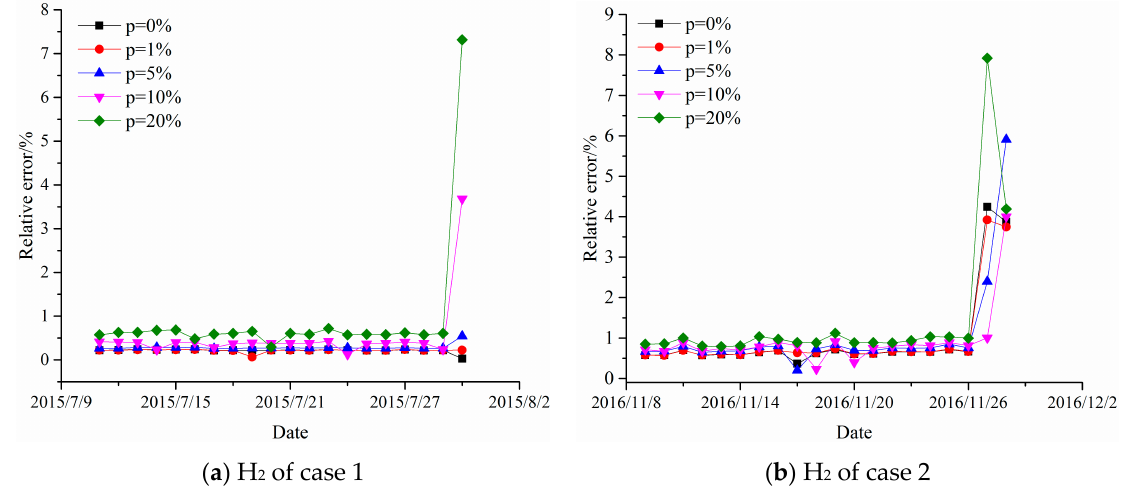
Figure 9. APE of forecasting result with different p.